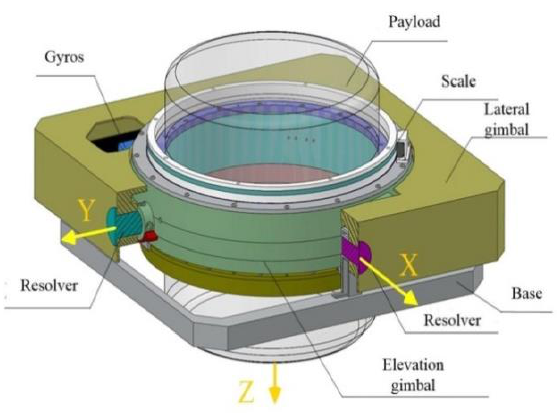
Figure 1. The MISP structure.